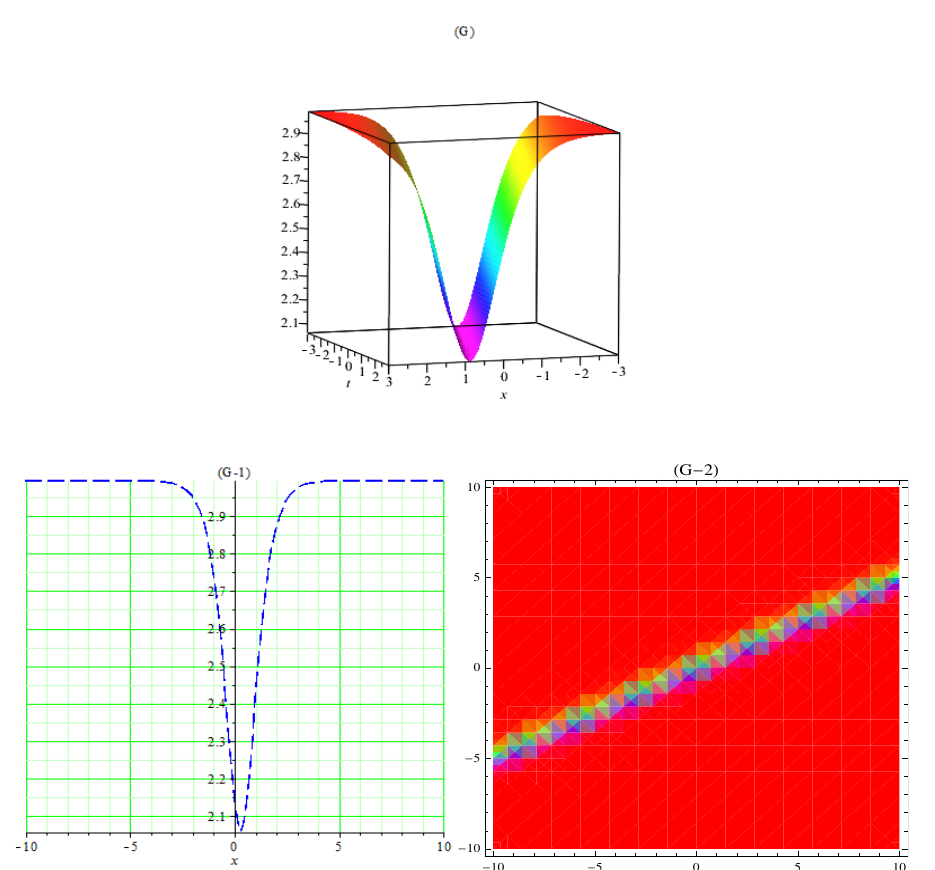
Figure 7. ( G ) 3D graph of dark soliton of (53) using l = 1.2, m = 0.2, µ = 0.4, A = 2.3, ζ = 0.6, V = 0.4, λ = 0.7. ( G-1 ) 2D plot and ( G-2 ) contour plot of